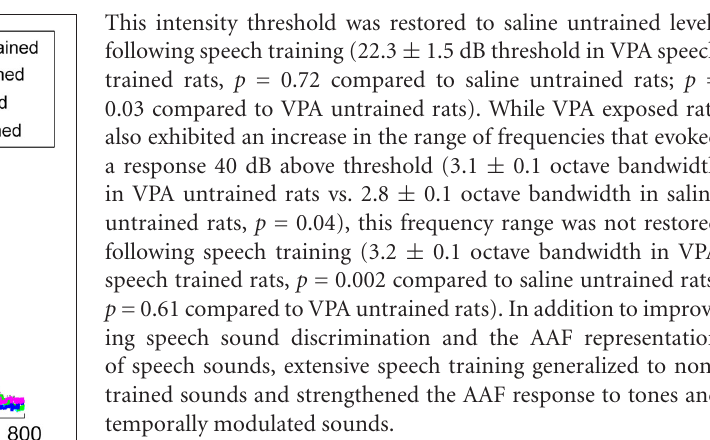
VPA exposed rats at intensities between 20 and 70 dB ( Figure 8 ).